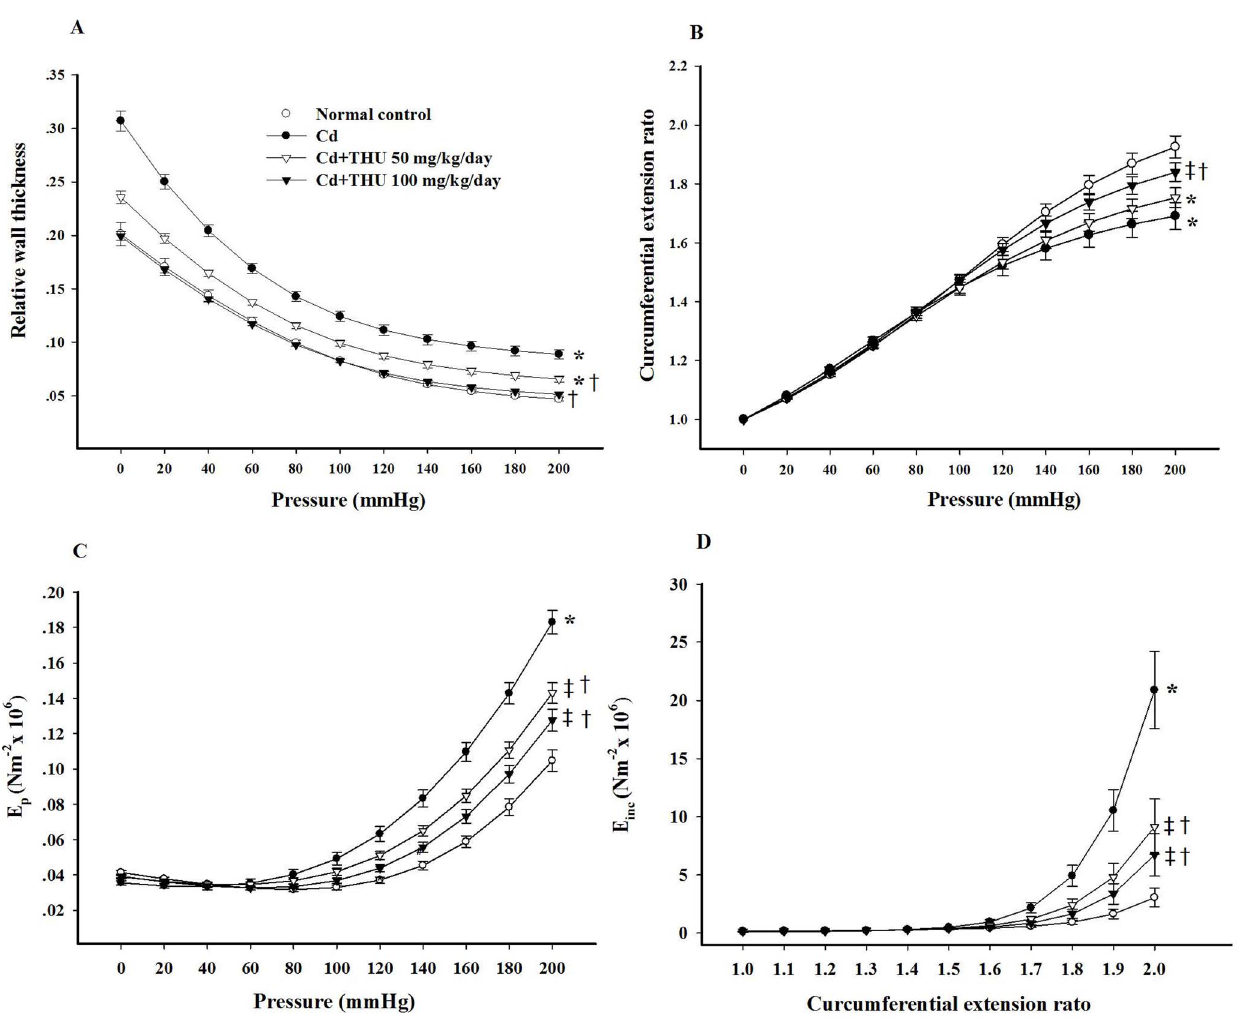
Fig. 3. Effect of THU on the relative wall thickness (A), circumferential extension ratio (B), E p (C), and E inc (D) of mice thoracic aortas in all experimental groups. Results are expressed as mean ¡ SEM., n 5 6–8/group. In animals not treated with Cd, THU has no effect on aortic elasticity of normal control mice (data not shown). (A) * P , 0.05 compared with normal control group at various pressures. { P , 0.05 compared with Cd control group at various pressures. (B) * P , 0.05 compared with normal control group at pressures ranging from 160–200 mmHg; { P , 0.05 compared with normal control group at pressures ranging from 180–200 mmHg); { P , 0.05 compared with Cd control group at pressures ranging from 160–200 mmHg. (C) * P , 0.001 compared with normal control group at pressures ranging from 100–200 mmHg; { P , 0.5 compared with normal control group at pressures ranging from 120–200 mmHg; { P , 0.05 compared with Cd control group at pressures ranging from 120–200 mmHg. (D) * P , 0.05 compared with all group (from 1.7); { P , 0.05 compared with normal control (from 1.9); { P , 0.05 compared with Cd control group (from 1.7).